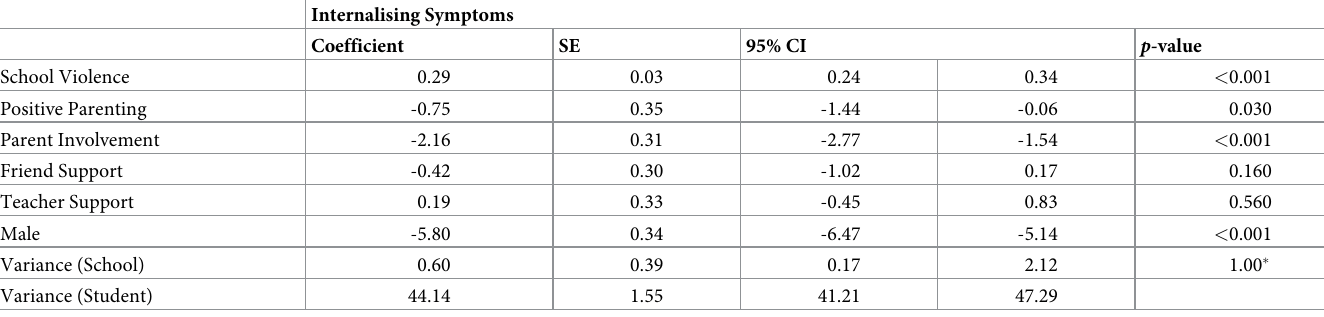
Table 9. Linear mixed-effects models of school violence & all sources of social support